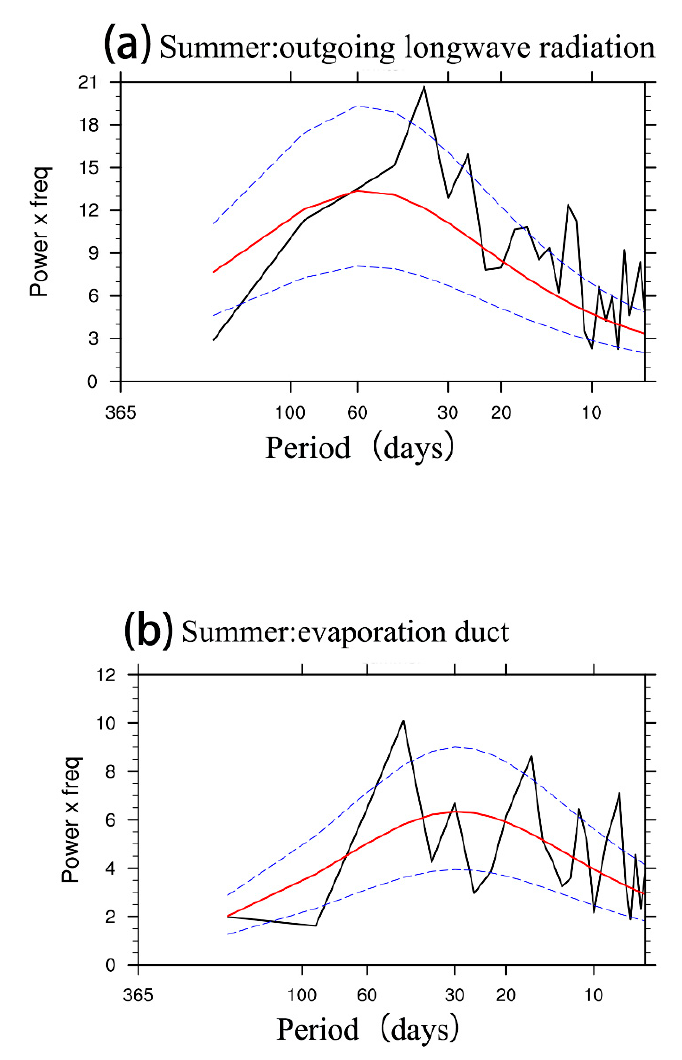
Figure 4. Power spectra of BSISO-related anomalies of the lower-tropospheric ( a ) OLR and ( b ) evaporation duct over the SCS in summer. The red curve represents the red-noise spectrum. The lower and upper blue dashed curves are the 5% and 95% red-noise significance levels, respectively.